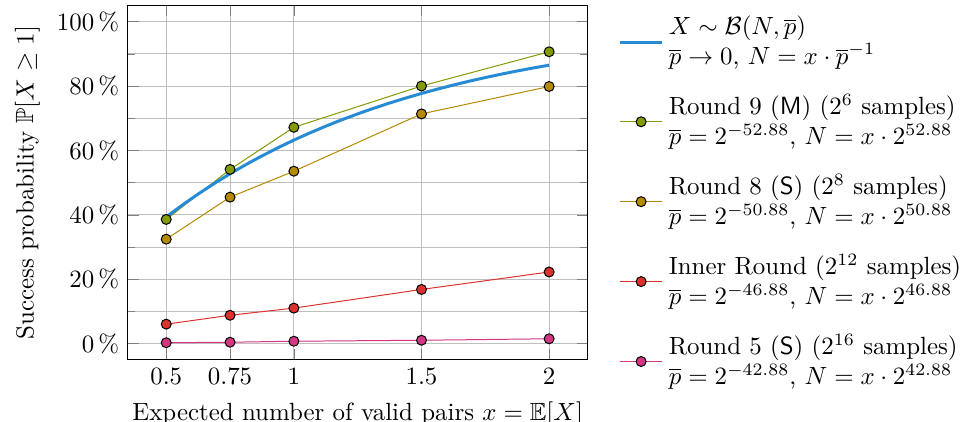
(b) Deviation of observed transition probability p f from estimate p f Figure 5: Experimental verification of estimated probability for a single fixed key and random keys . Empty marks , indicate a low sample size ( < 10).